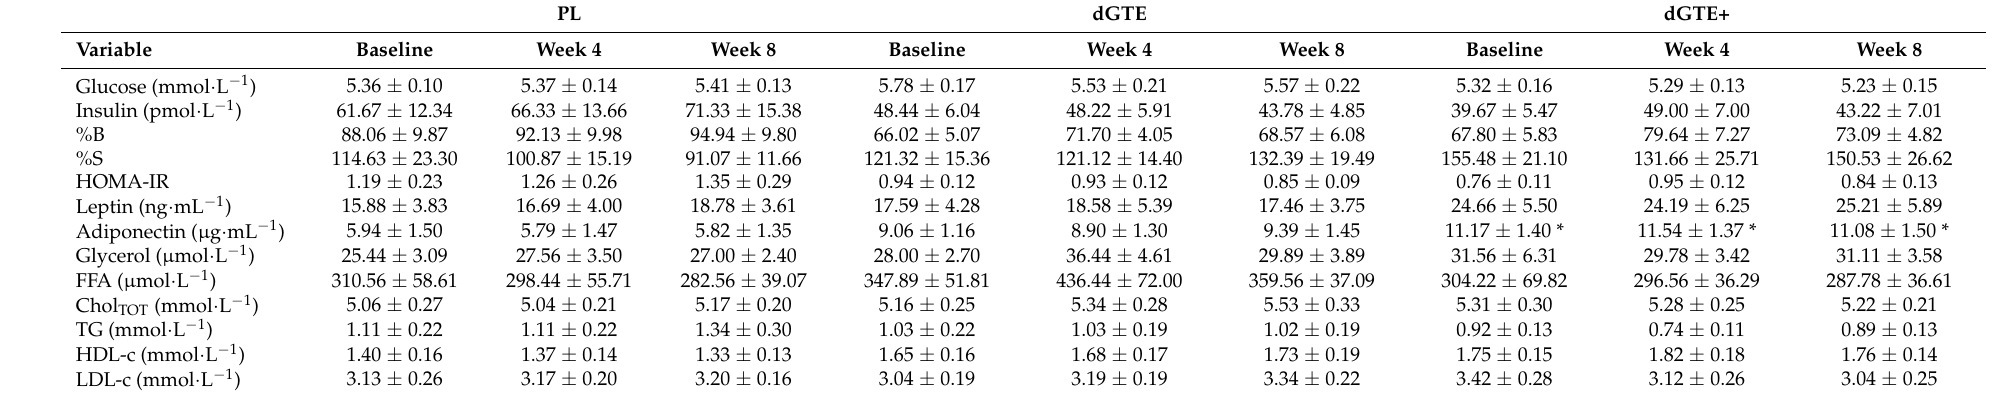
Table 7. Mean serum cardio-metabolic markers at baseline (week 0), week 4 and 8 between intervention groups.